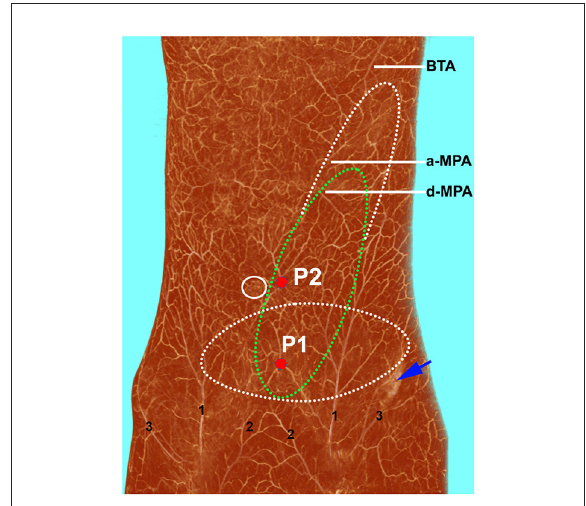
FIGURE2 Three-dimensional visualization of the abdominal wall of a female cadaver after angiographic injection. The perforasome of the DIEP flap are linked to many other perforasome via “choke vessels” in the subdermal plexus. The transverse (white dotted ellipse) and oblique (green dotted ellipse) DIEP flap designs can be safely harvested using perforator 1 (P1). If perforator 2 (P2) is chosen, an oblique extended DIEP flap can also be safely harvested, as the distal part of the flap is also composed of dynamic territories. DIEP, deep inferior epigastric perforator; BTA, brachiothoracic artery; a-MPA, ascending branch of the musculophrenic artery; d-MPA, descending branch of the musculophrenic artery; 1, superficial inferior epigastric artery; 2, superficial external pudendal artery; 3, superficial iliac circumflex artery.